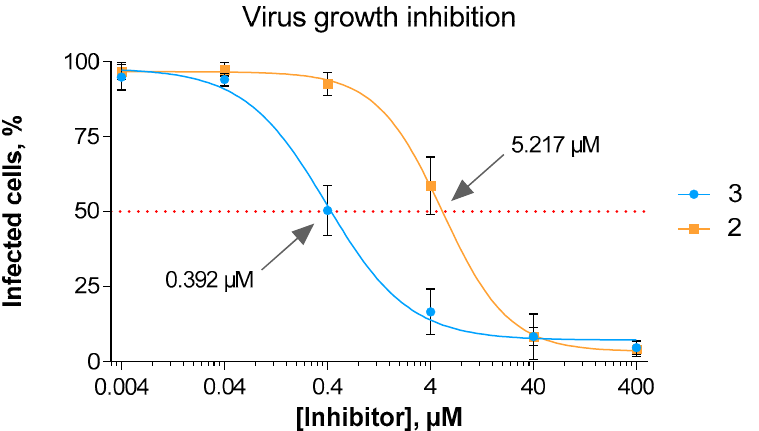
Figure 4. hPIV-1 growth inhibition by compounds 2 and 3. The data represents the mean of three independent experiments; the error bars represent the calculated standard deviation (SD).